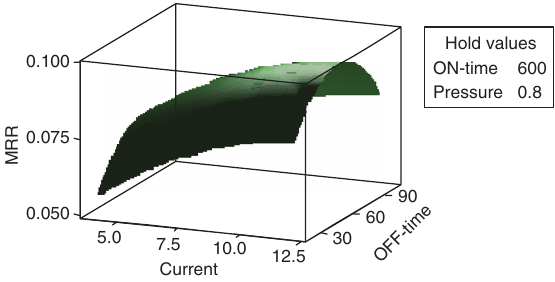
Figure 7 Surface plot of MRR vs. off time, current.